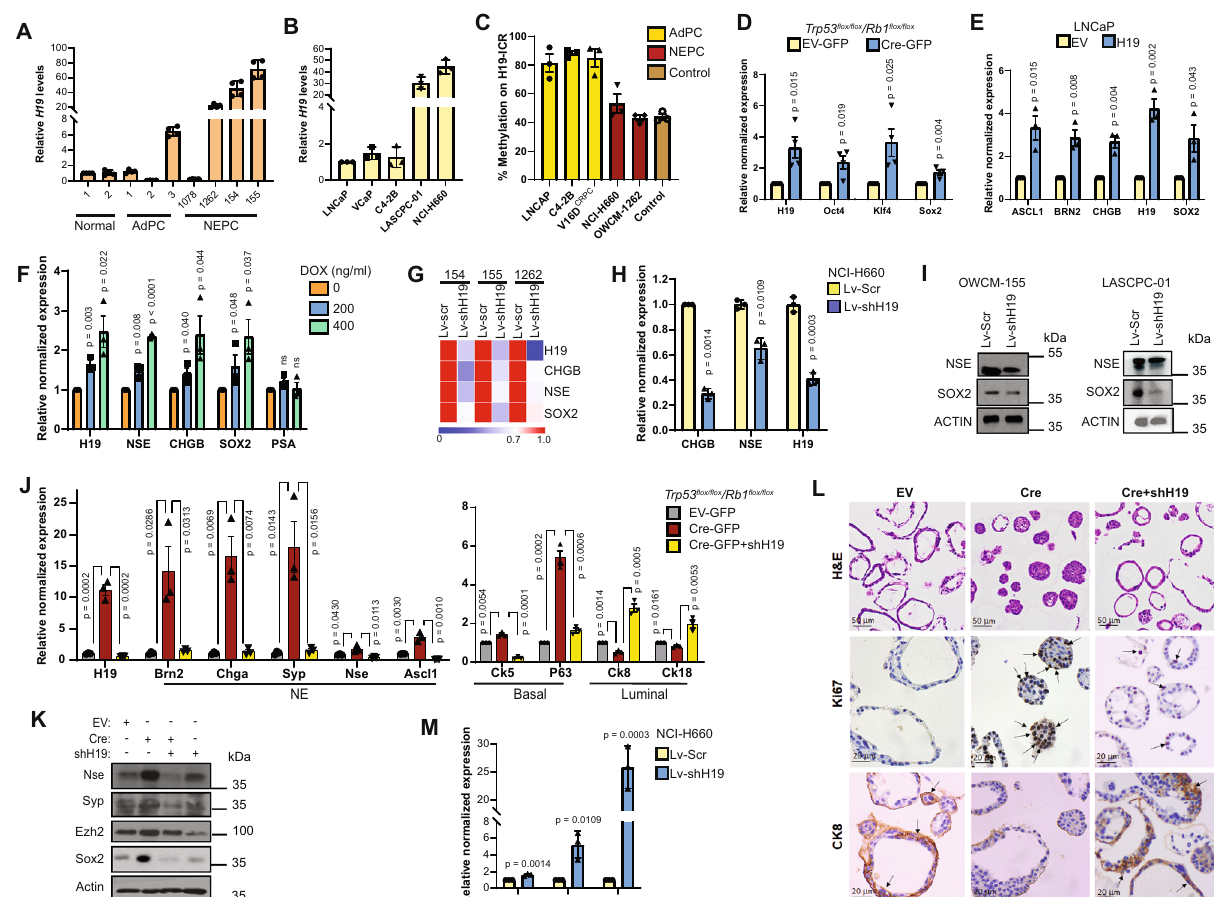
Fig. 3 H19 is elevated in NEPC organoids and cell lines and controls the expression of stem cell and NE markers. Relative H19 expression in A patient- derived organoids from normal (1 – 2) biopsy, AdPC (1 – 3), and NEPC (OWCM-154, 155, 1078, 1262) and B AdPC (LNCaP, C4-2B and VCAP), and NEPC cell lines (LASCPC-01 and NCI-H660). C Percent methylation on IGF2/H19 -Imprinting control region (H19-ICR) derived by Methyl meter assay in representative control (see Supplementary Methods), AdPC, CRPC, and NEPC cell lines. The normal imprinting range was de fi ned as 40 – 60% methylation. D Relative RNA expression of indicated genes after Trp53/Rb1 DKO induced by lentiviral transduction of Cre-recombinase in Trp53 fl ox/ fl ox / Rb1 fl ox/ fl ox mouse prostate organoids (Cre-GFP) vs. control transduced organoids (EV-GFP). E Relative RNA expression of H19 and NE markers in LNCaP overexpressing H19 vs. control (EV). F Relative RNA expression of indicated genes in doxycycline (DOX) inducible H19 FL C4-2B cells upon DOX treatment (0, 200, 400 ng/ mL; 48 h) (see also Fig. 6F). G Heat map of relative RNA expression of indicated genes in control (Lv-Scr) and H19 knockdown (Lv-shH19) NEPC organoids. H Relative RNA expression of indicated genes after H19 knockdown in NCI-H660 cells (Lv-shH19) vs. control transduced cells (Lv-Scr). I Western blot (WB) of SOX2 and NSE in control (Lv-Scr) and H19 knockdown (Lv-shH19) OWCM-155 and LASCPC-01. J Relative RNA expression of representative lineage-speci fi c genes in mouse prostate organoids after Trp53/Rb1 DKO induced by lentiviral transduction of Cre-recombinase (Cre-GFP) into Trp53 fl ox/ fl ox / Rb1 fl ox/ fl ox mouse prostate organoids. H19 knockdown is denoted as Cre-GFP + shH19. EV transduced organoids (EV-GFP) were used as controls. # p - values < 0.05 vs. EV-GFP organoids. * p -Values < 0.05 vs. Cre-GFP organoids. K WB of representative NE genes in the Trp53 fl ox/ fl ox / Rb1 fl ox/ fl ox mouse prostate organoids transduced with EV, Cre, Cre + shH19, or shH19. L Representative images showing H&E staining (scalebar 50 µ m) and immunostaining (scalebar 20 µ m) for Ki67 and CK8 in the same organoids from ( J ). Arrows represent areas of intensive staining. M Relative RNA expression of luminal markers after H19 knockdown in NCI-H660 cells (Lv-shH19) vs. control transduced cells (Lv-Scr). Data are mean ± SD ( A , B , H , M ), or mean ± SEM ( C , D , E , F , J ); n = 3 ( B , C , E , F , H , J , M ) or n = 4 ( A , D ) biologically independent replicates. p Values were calculated by unpaired two-tailed Student ’ s t